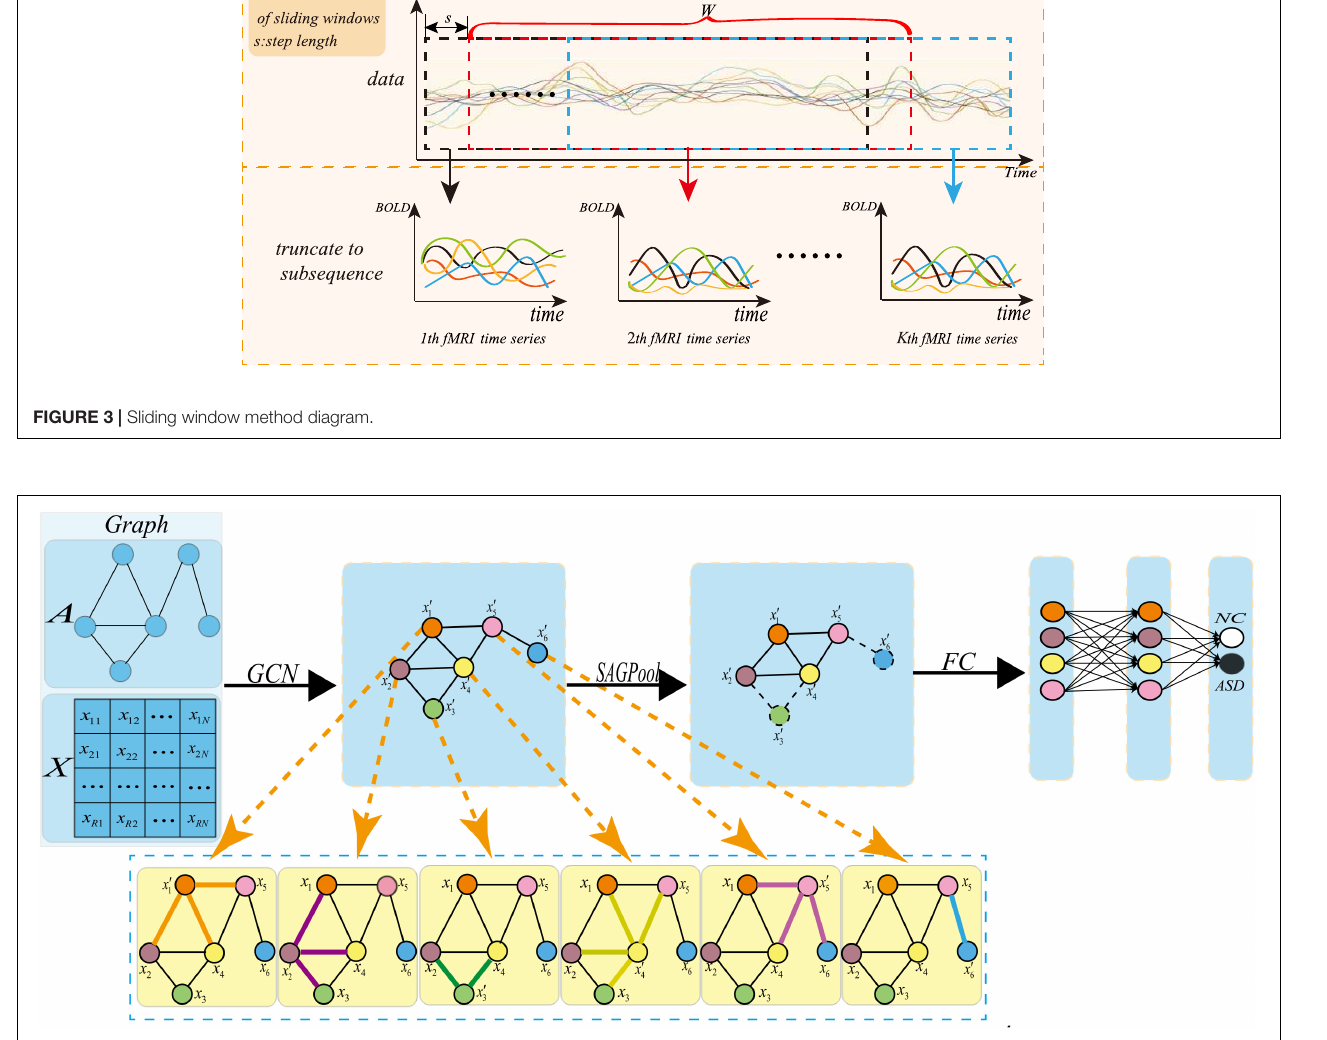
FIGURE 4 | Pooling operation. Where x i represents the feature vector of the i − th node, x (cid:48) i represents the feature vector of the i − th new node obtained after the graph convolution. After the pooling operation, a new graph is obtained, in which the dotted line indicates that the corresponding node should be discarded.